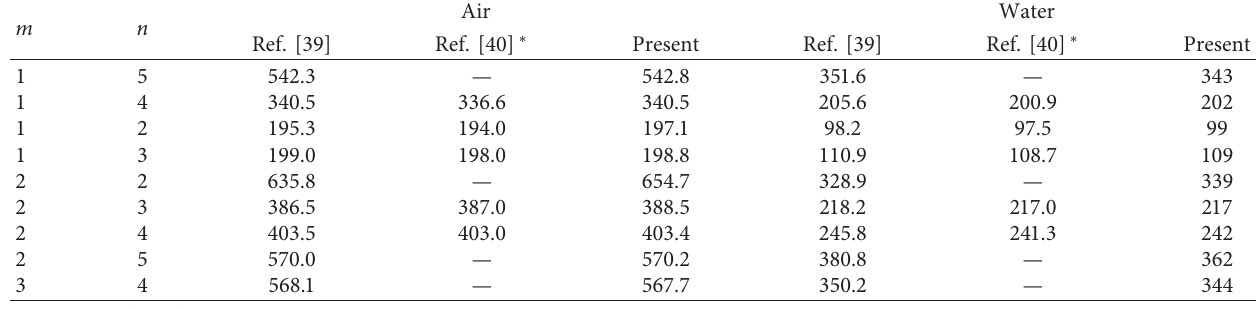
Table 1: Comparison of values of the natural frequency (Hz) for a shell L � 1.284m, a � 0.18m, and h �